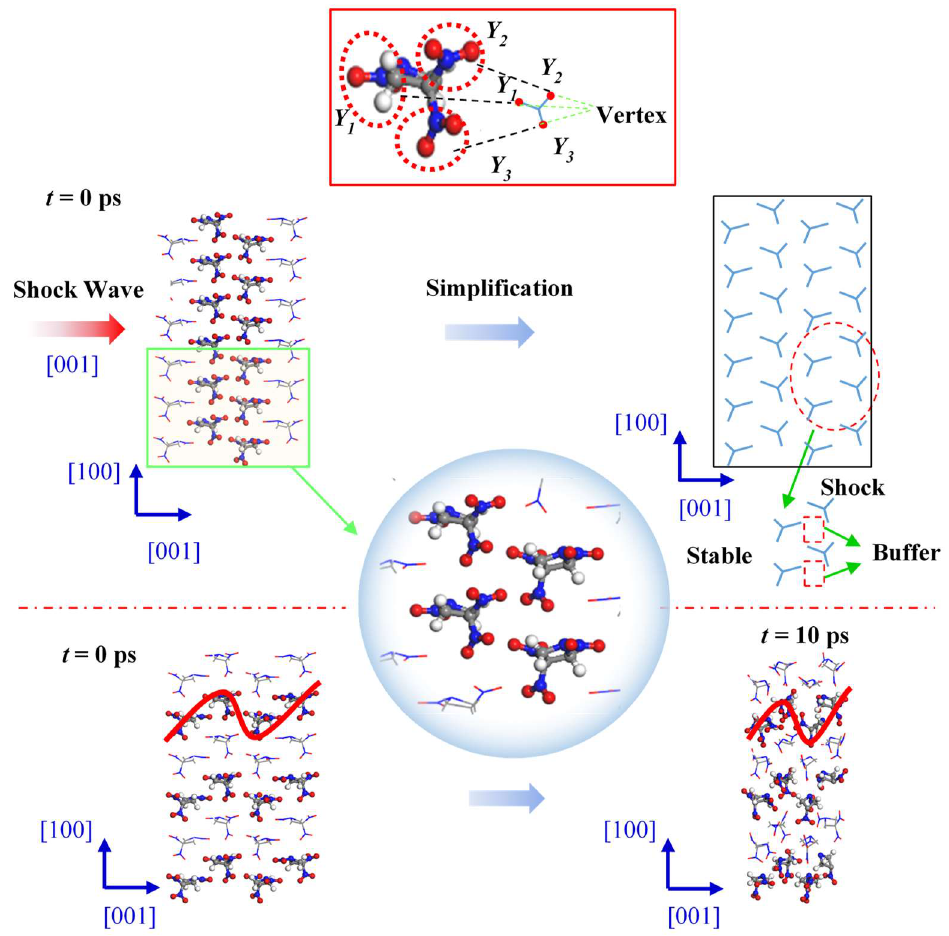
Figure 7. Molecular arrangement of TNAZ in the [001] direction. Table 3. Number of TNAZ molecules and other small molecules in the [001] direction.